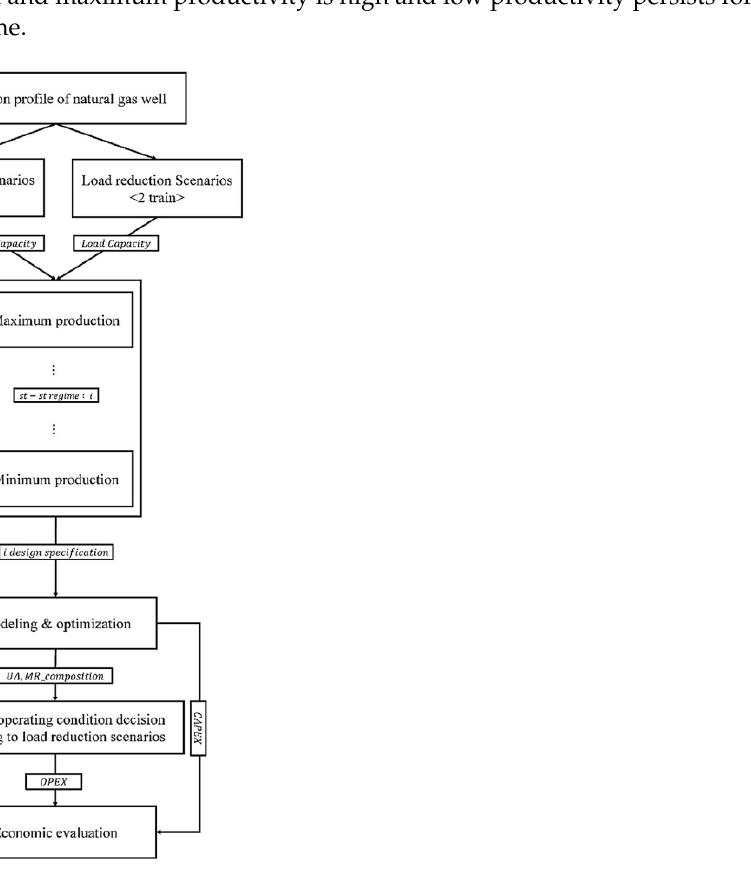
Figure 32. Arrangement of HK/LK control structure [111].